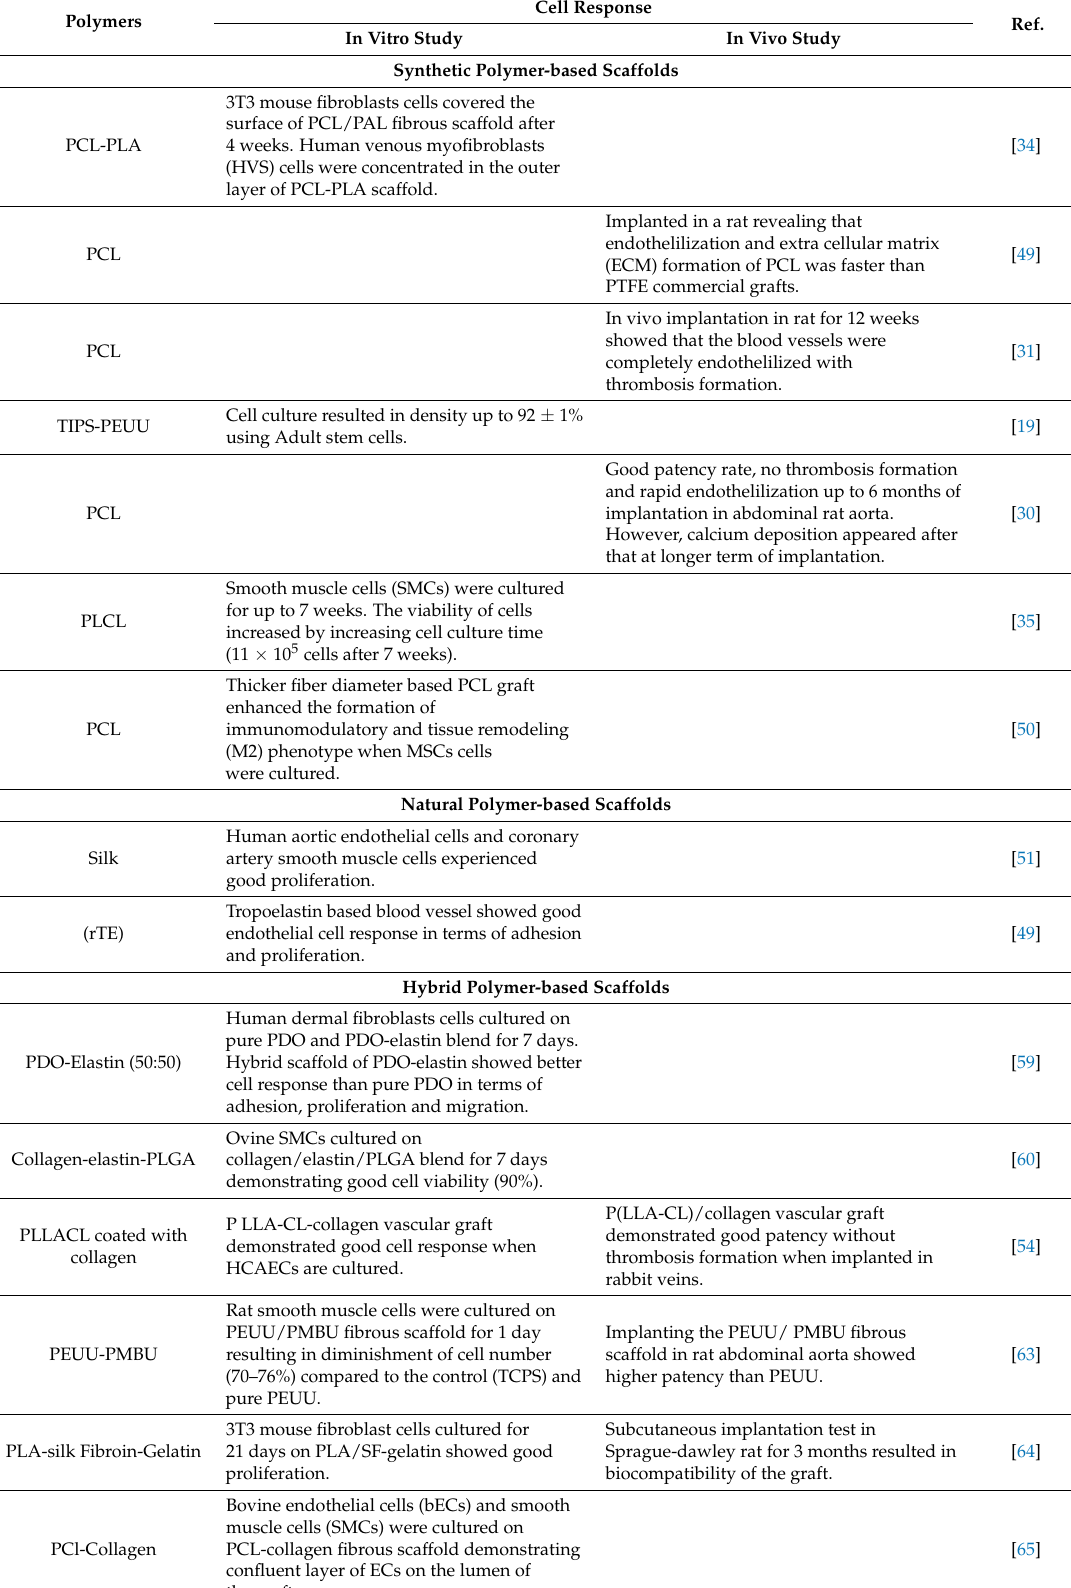
Table 3. Polymers used for the fabrication of small diameter blood vessels and their biostudies. Polymers